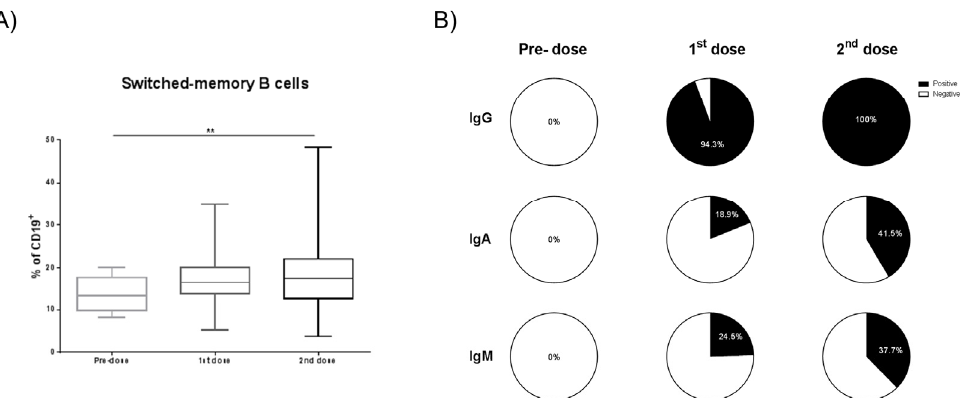
Figure 6. B-specific SARS-CoV-2 vaccine assessment. The frequency of switch-memory B cells ( A ) within CD19+ cells in peripheral blood, prior immunization (Pre-dose), after the first and the second doses (1st and 2nd doses, respectively) is depicted. The frequency of specific anti-SARS-CoV-2 IgG, IgA, and IgM antibodies before immunization (Pre-dose), after the first and the second doses (1st and 2nd dose, respectively) is shown ( B ). Wilcoxon test was used to median comparison in A and B, ** ( p < 0.01).